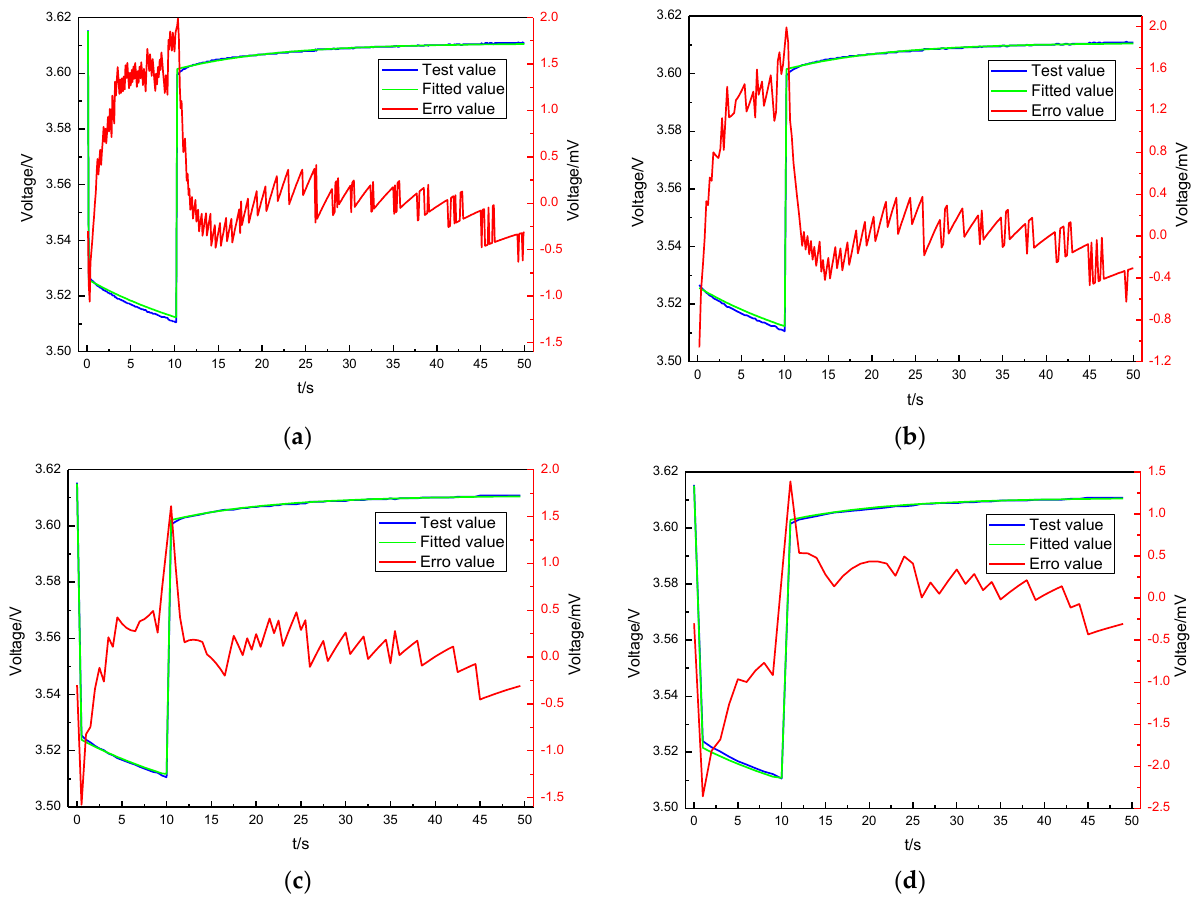
Figure 7. Voltage curves of the discharge and relaxation periods of 1-RC circuit model at SOC = 0.4: ( a ) ∆ t = 0.1 s; ( b ) ∆ t = 0.2 s; ( c ) ∆ t = 0.5 s; ( d ) ∆ t = 1.0